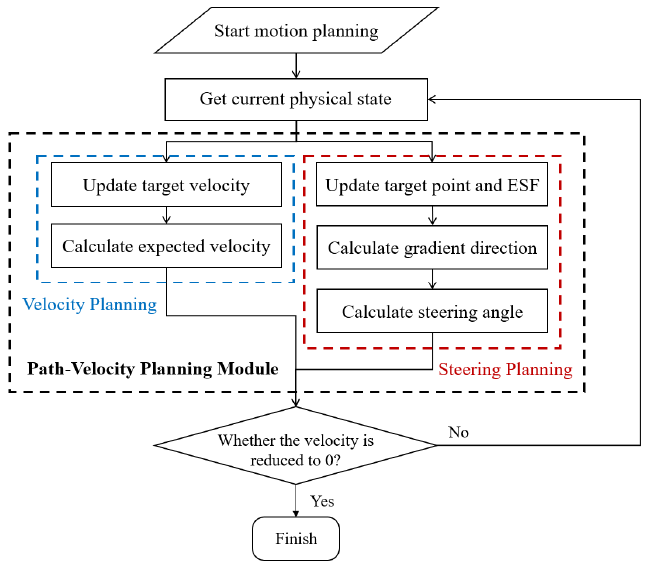
Figure 10. The running process of motion